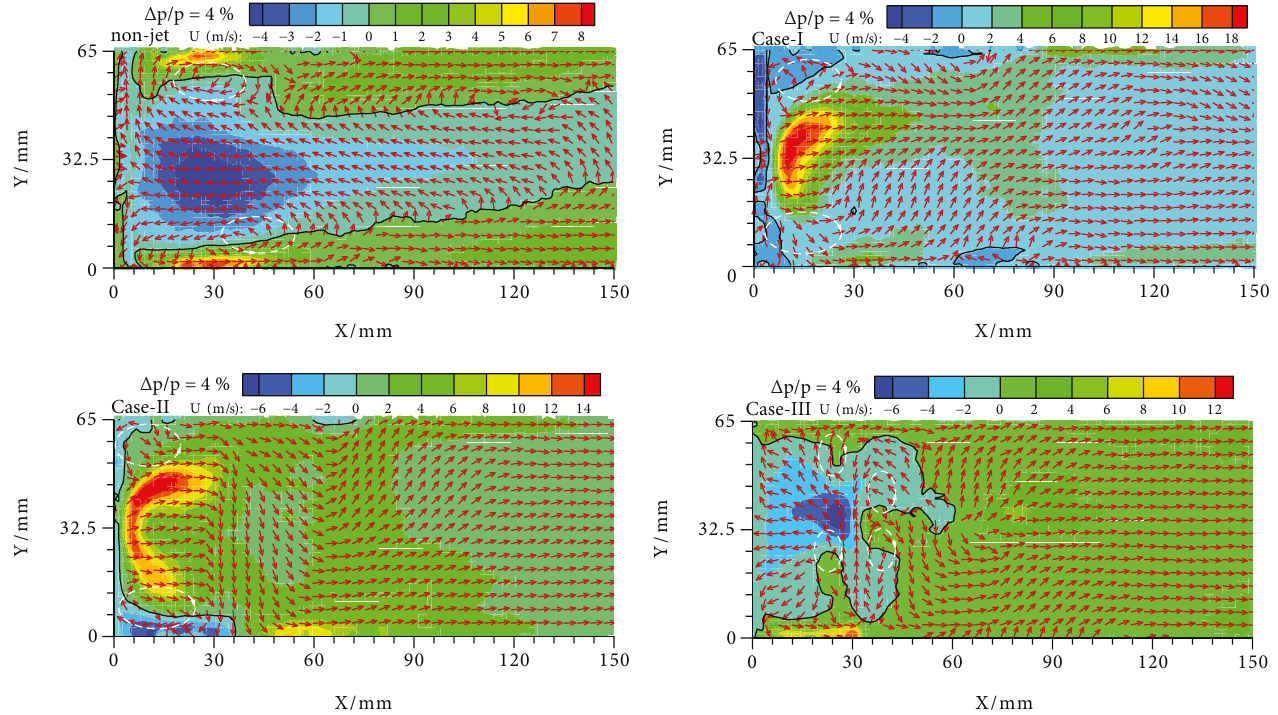
Figure 7: Axial velocity contours and velocity vector plots on the Z = − 15 5mm